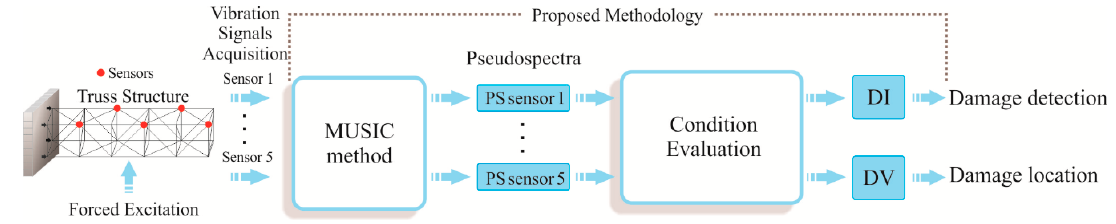
Figure 3. Schematic diagram of the proposed methodology.